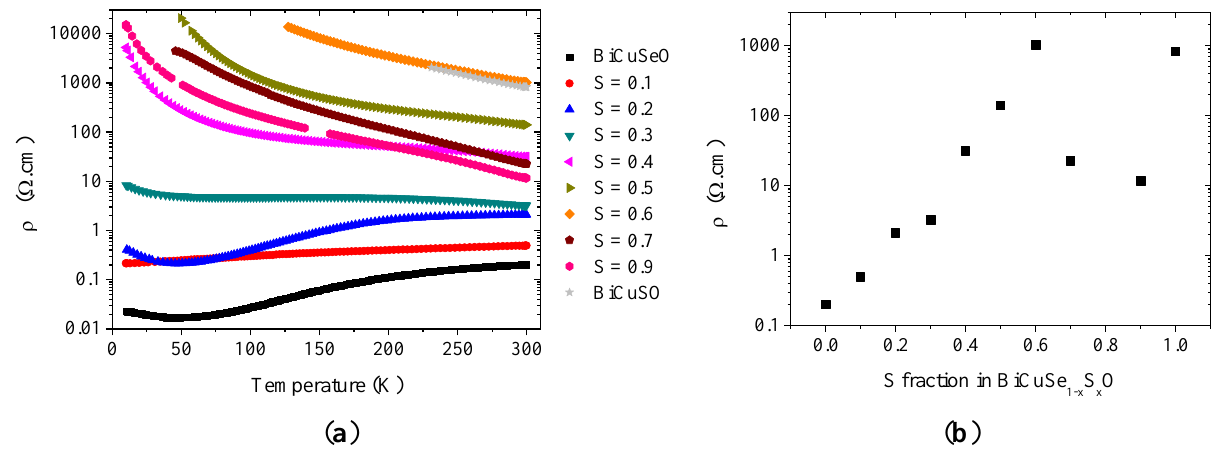
Figure 8. Temperature dependence ( a ) and evolution of the room temperature value of the electrical resistivity ( b ) in the BiCuSe 1−x S x O solid